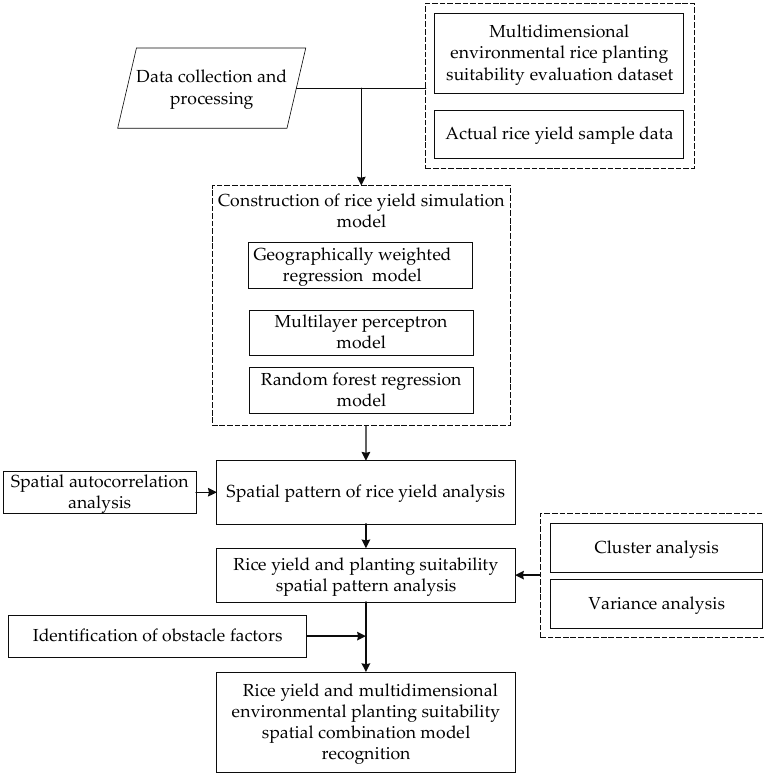
Figure 3. Flow chart of the